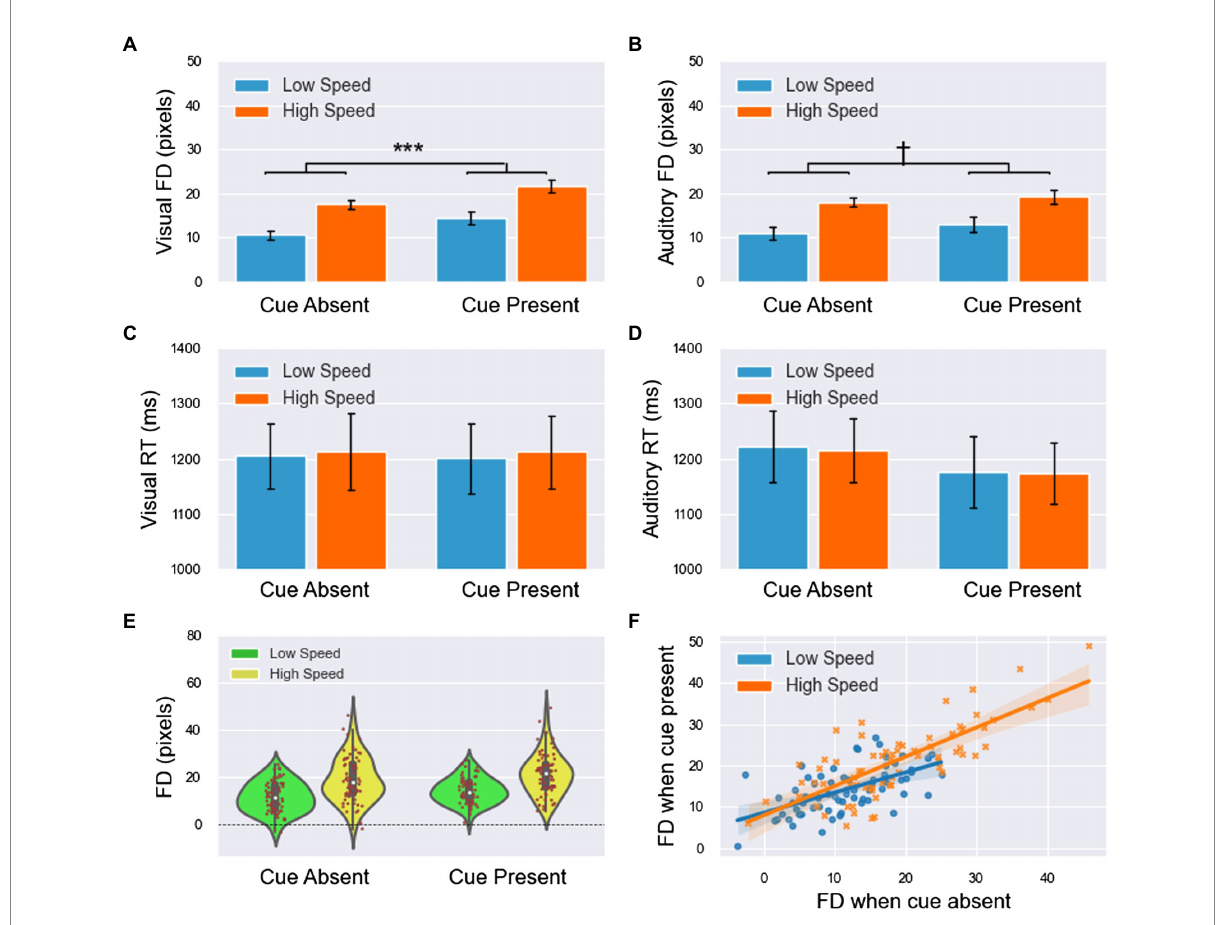
FIGURE 3 The results of forward displacement (FD) and response time (RT) in experiment 2 (all main effects are not labeled in the figure). (A,B) The means of FD in the visual and auditory blocks. (C,D) The means of RT in the visual and auditory blocks. (E) The cue shifted the distribution of FDs to higher values (including both visual and auditory blocks), and when the speed was high, the FDs were larger and more dispersed. (F) The linear relationship of FDs between the cue-absent and cue-present conditions had a slope of less than 1, which indicated that if observers’ mental extrapolation was easier when they were not alerted, then the effect of the alerting cue would be smaller. This finding suggested that the effect of the cue had an upper limitation. Moreover, the slopes of the two lines were roughly identical, which indicated that the effect of the cue on FD was not modulated by speed. All significance level markings are as follows: † p < 0.1, * p < 0.05, ** p < 0.01, *** p <